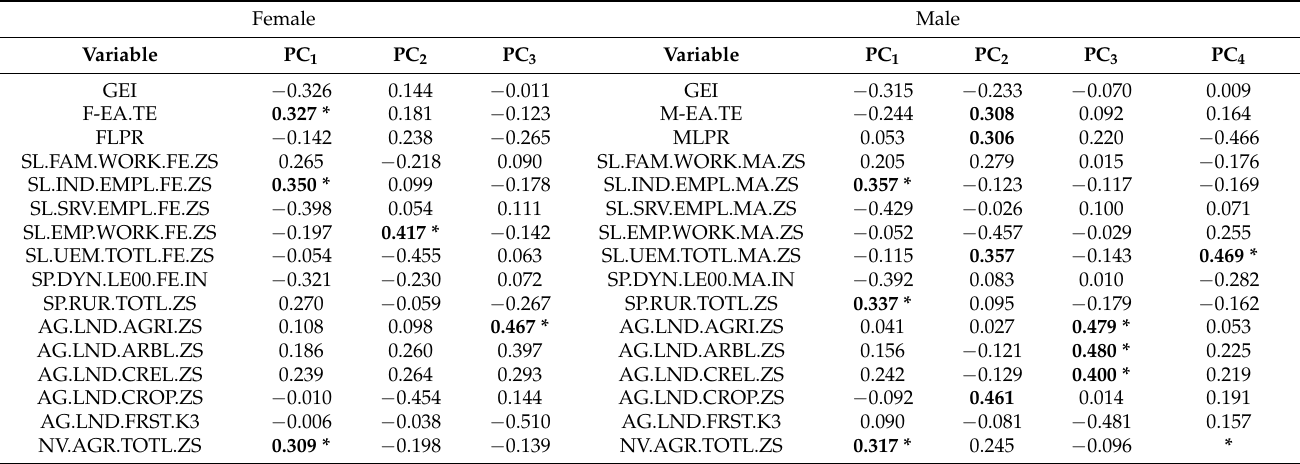
Table 6. Scoring coefficient derived from rotated factor matrix characterising the first main compo- nents (f vs.